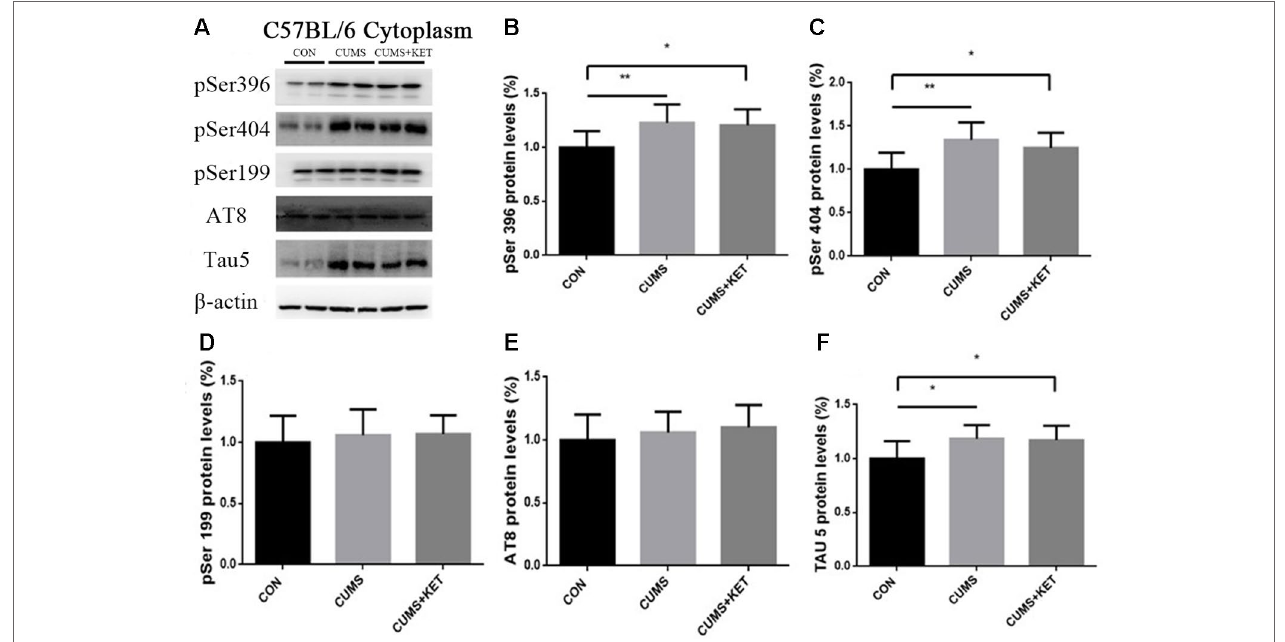
FIGURE 4 | The effects of CUMS and ketamine on Tau protein in the cytoplasm of the hippocampus of C57BL/6 mice. (A) Total Tau and hyperphosphorylated Tau protein in the cytoplasm of the hippocampus. (B, C, and F) After CUMS, the levels of pSer396, pSer404, and total Tau protein increased; ketamine did not change cytoplasm levels. (D and E) Levels of pSer199 and AT8 of Tau protein did not change after CUMS or ketamine treatment. Data are expressed as mean ± SD; n = 10 per group. One-way ANOVA was used to compare differences among the CON, CUMS, and CUMS+KET groups.